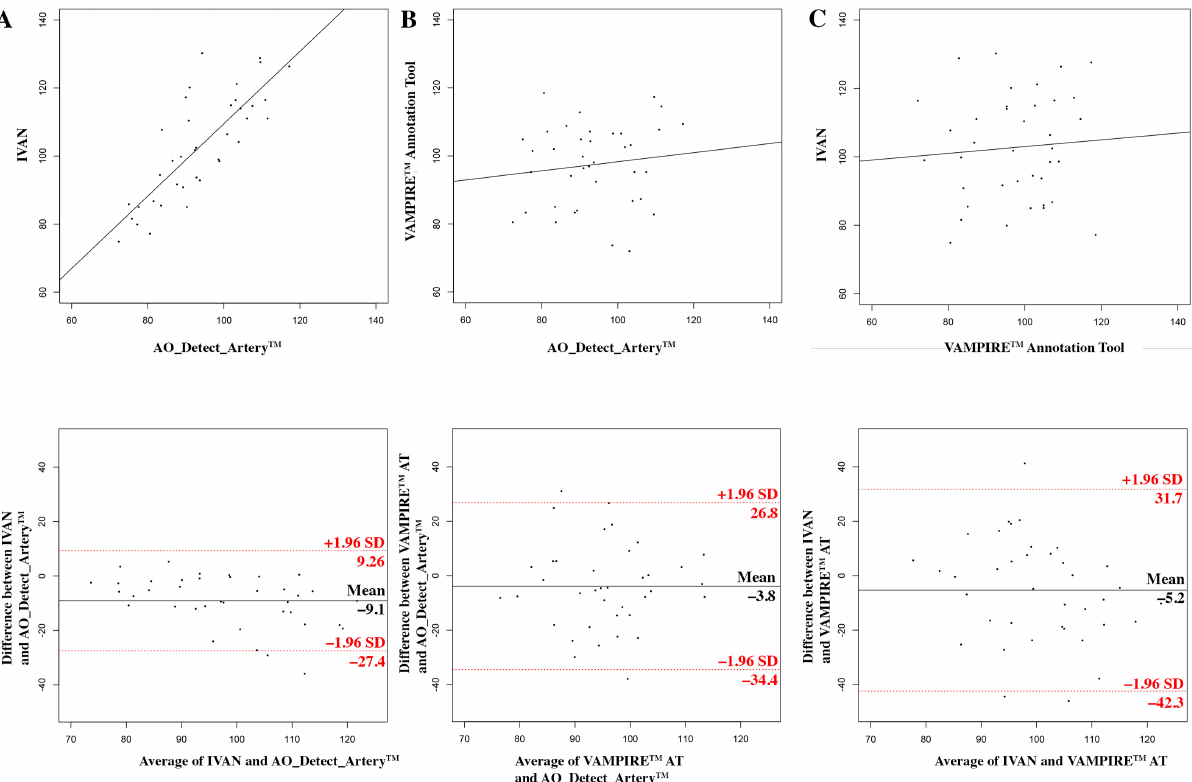
Figure 2. Estimated distributions of diameter values by software tool, for artery measurements ( A ) and vein measurements ( B ) and software tool.